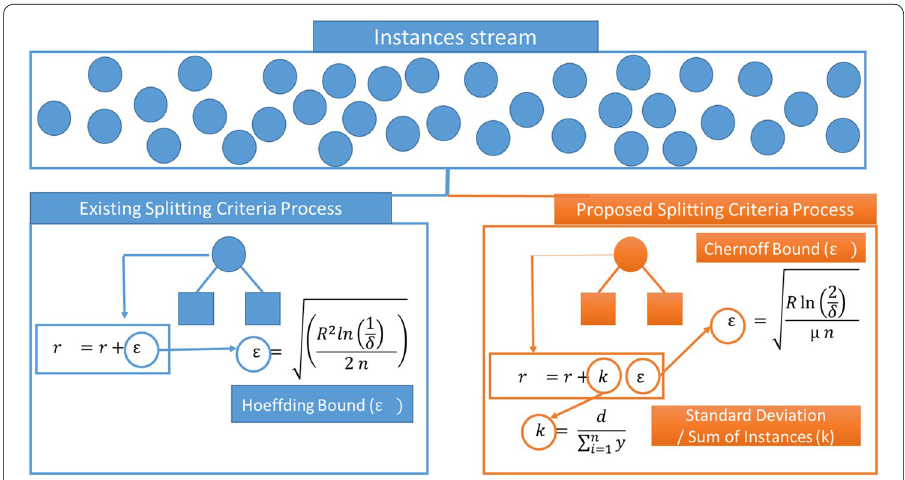
Fig. 1 Illustration of our proposed splitting criteria